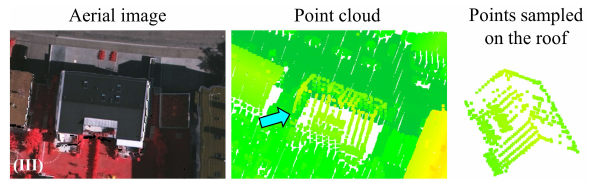
Figure 7. Building not identified by the proposed mehtod. The cyan arrow indicates the ommited building.